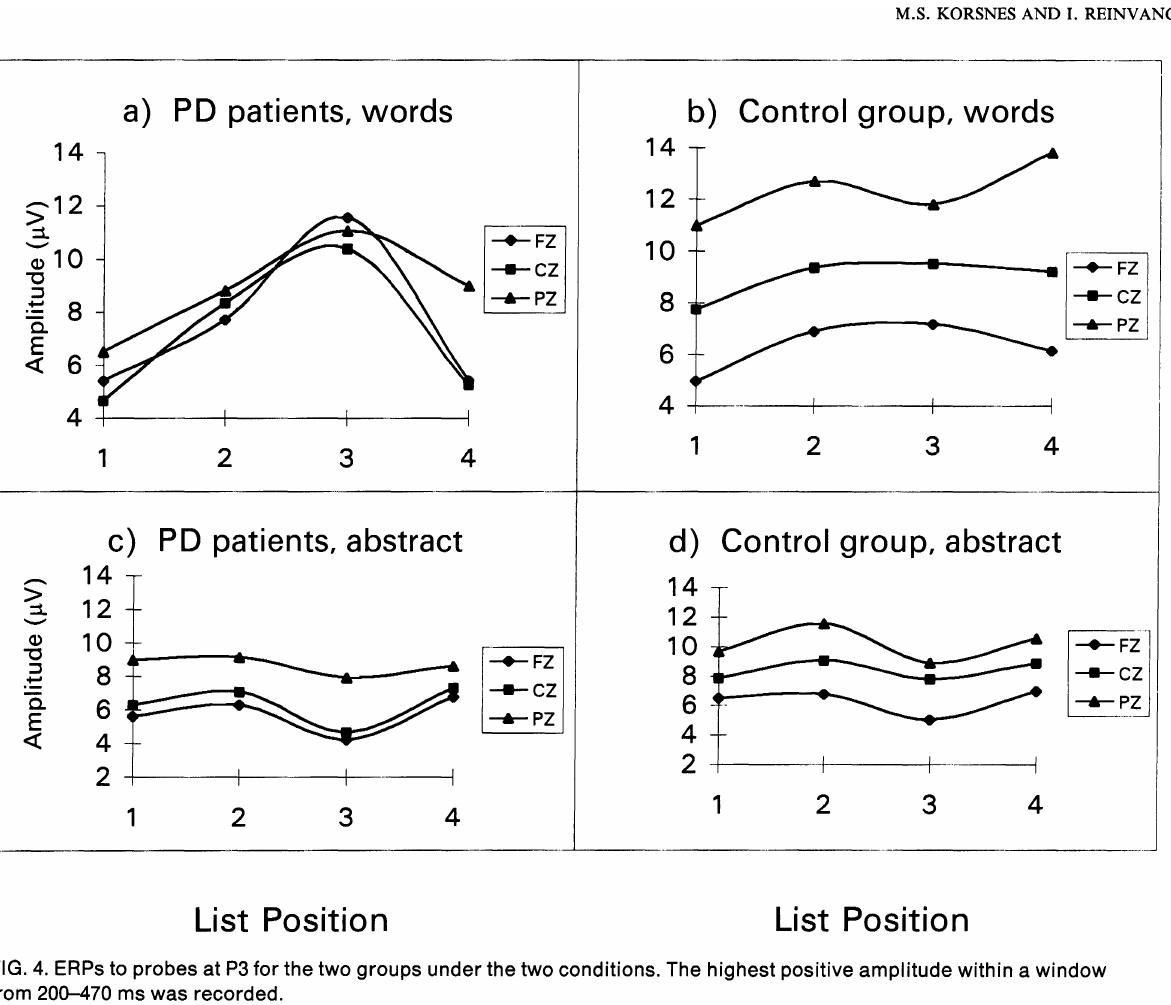
FIG. 4. ERPs to probes at P3 for the two groups under the two conditions. The highest positive amplitude within a window from 200--470 ms was